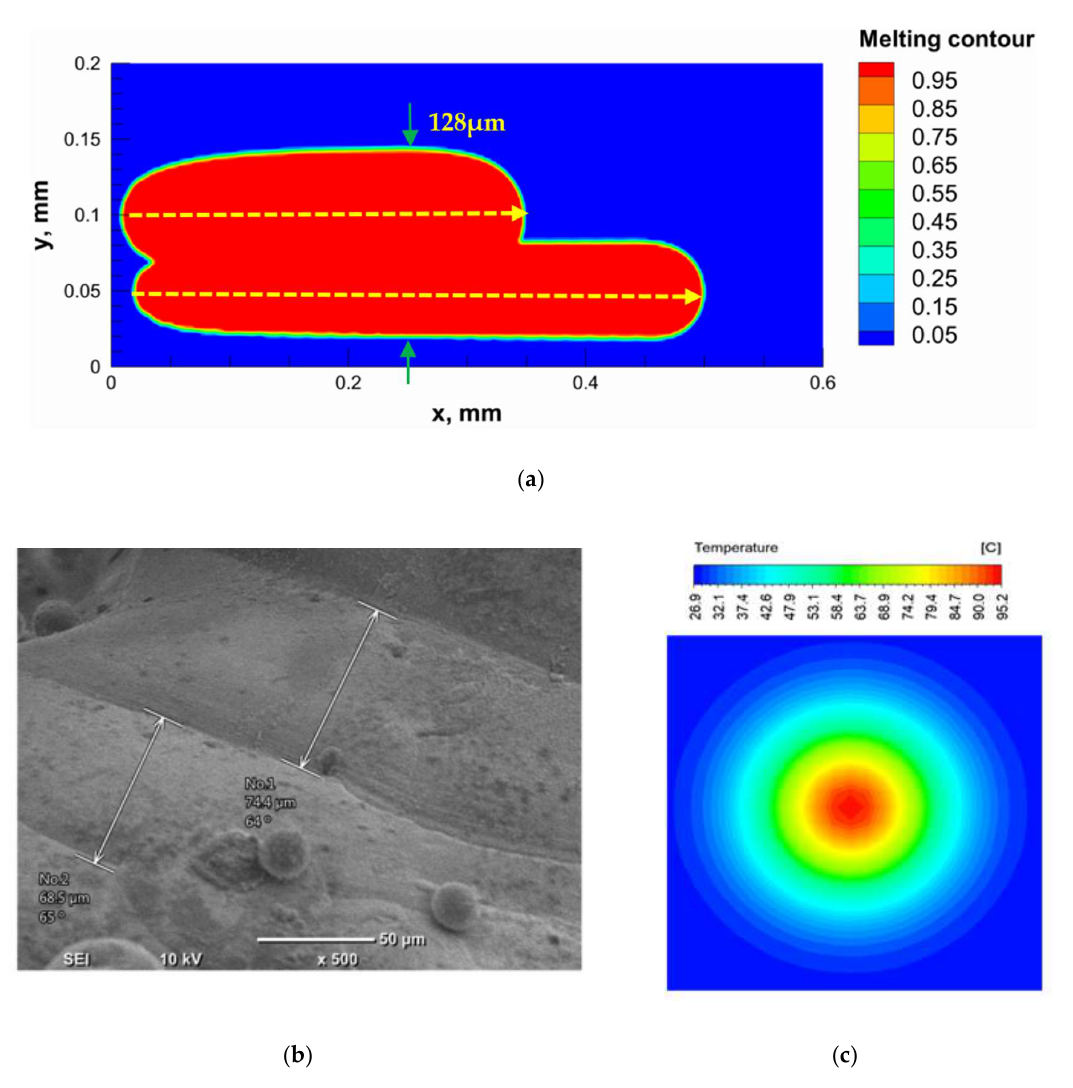
Figure 9. Validation of the experimental data with numerical model: ( a ) SEM images for two adjacent melting paths; ( b ) melting contour for two adjacent melting paths; ( c ) temperature distribution for the laser spot obtained from the numerical model.